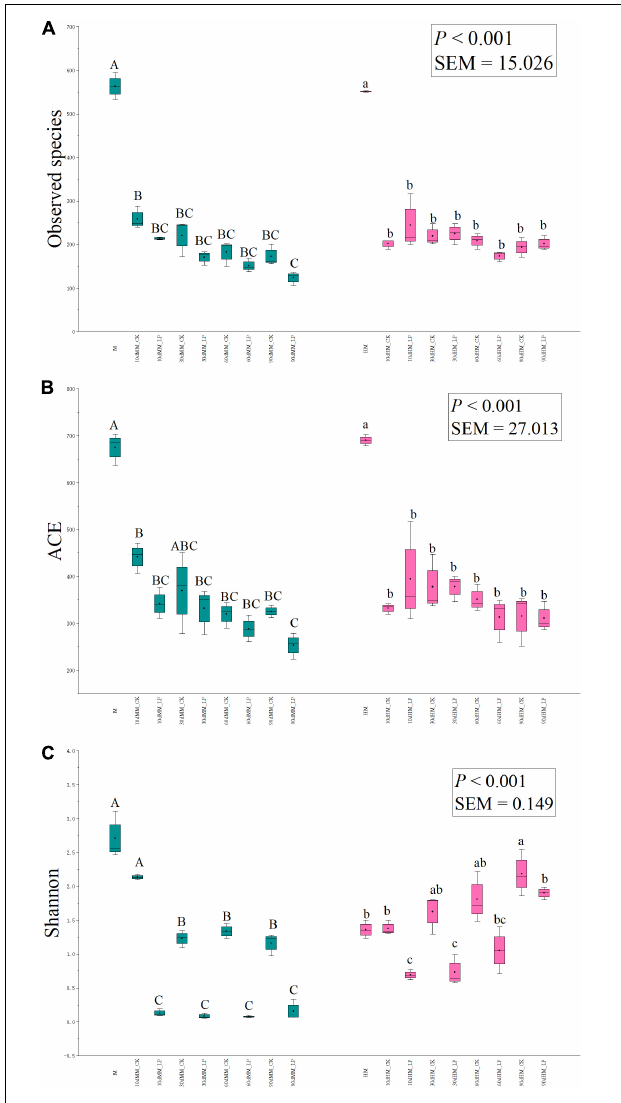
FIGURE 4 | Box-plots of observed species (A) , ACE (B) , and Shannon (C) indices of bacterial communities in alfalfa silage at 10, 30, 60, and 90 days. HM, not wilted before ensiling; MM, wilted before ensiling; CK, silage without inoculation; LP, silage inoculated with L. plantarum A345. Values with different capital letters indicate significant difference among samples in the wilted group ( P < 0.05); Values with different small letters indicate significant difference among samples in the non-wilted group ( P < 0.05). SEM, standard error of